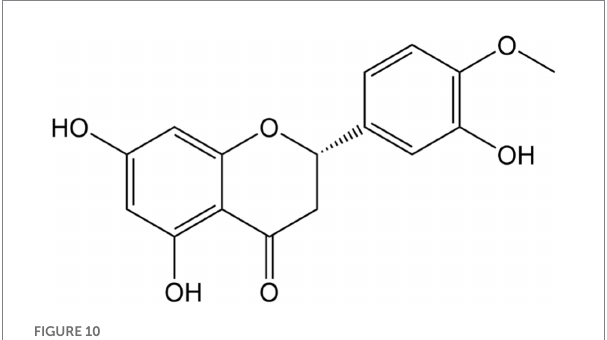
FIGURE 10 Chemical structure of hesperetin.